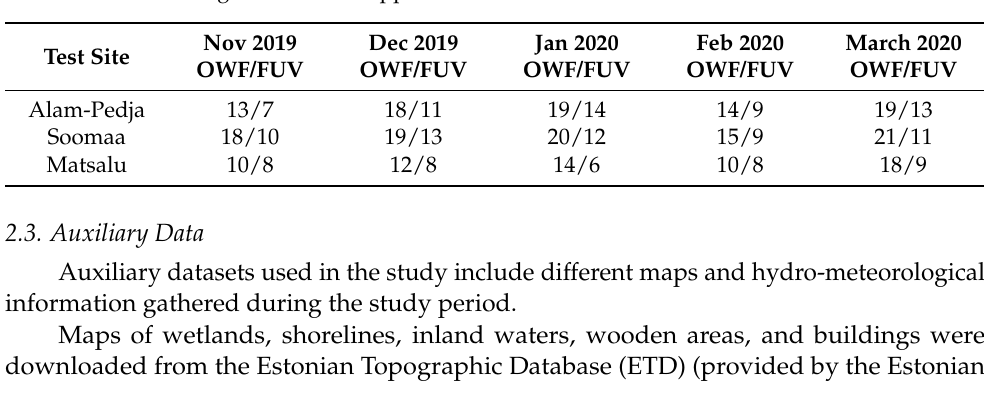
Table 3. Number of images included in analysis per month per test site. OWF represents the number of images from which open-water flood was mapped. FUV represents the number of images from which flood under vegetation was